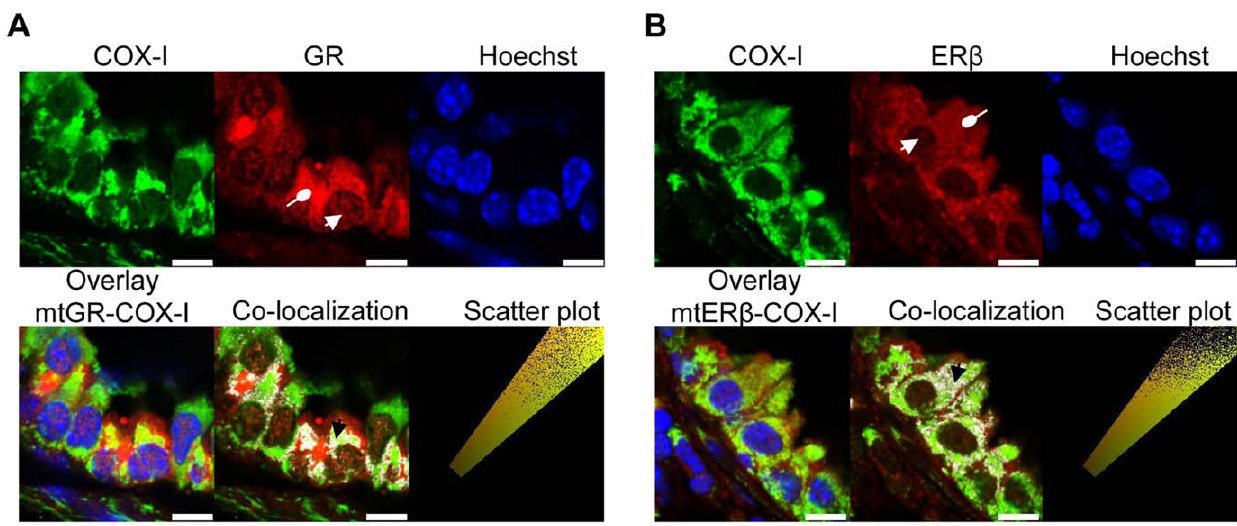
Figure 3. Cells from bronchial epithelial layer express both GR and ER b receptor in mitochondria. Representative immune-fluorescent images of antibodies against COX-I (green), GR (red), ER b (red) and Hoeschst (nuclear fluorescence stain, blue) were obtained with confocal laser scanning microscopy. Yellow co-localized pixels in overlay images for (A) mtGR-COX-I and, (B) mtER b -COX-I are depicted. Co-localisation analysis and quantification were performed using the Leica Las-AF image system, where background and threshold were set, generating a colocalization image (colocalized pixels in white; black arrow head) and a pixels distribution scatter plot (co-localized yellow pixels along the diagonal). White point arrow head shows nuclear distribution and white rounded arrow head shows cytoplasmic distribution. Scale bars, 7.5 m